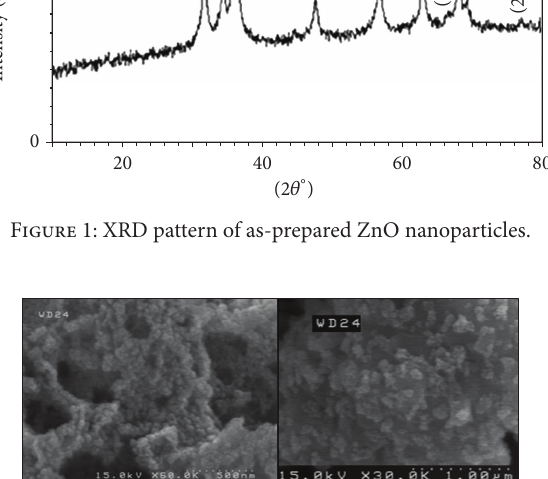
times and then with ethanol to remove unreacted materials.